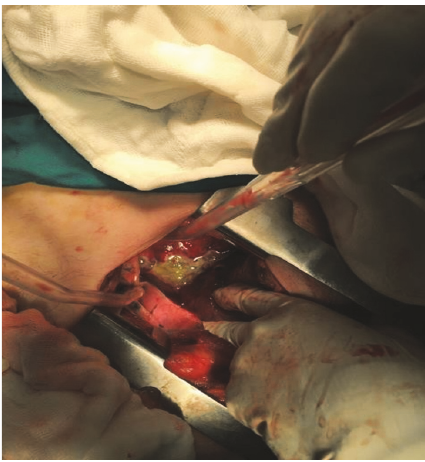
Figure 4: Lung cystotomy with subcostal incision.